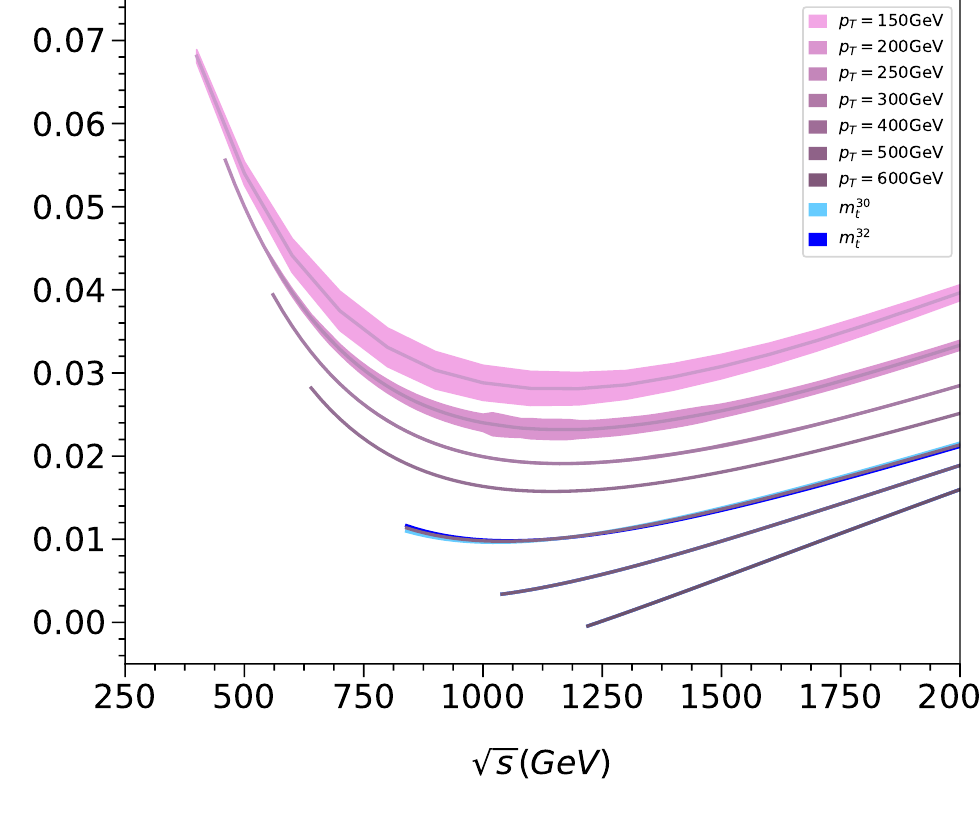
√ Figure 4. V fin as a function of s for eight values of p T , at the scale µ 2 = s . The uncertainty estimate of the Padé procedure is displayed as light-coloured bands. For p T ≥ 400 GeV, we also show two high-energy expansion curves including terms up to order m 30